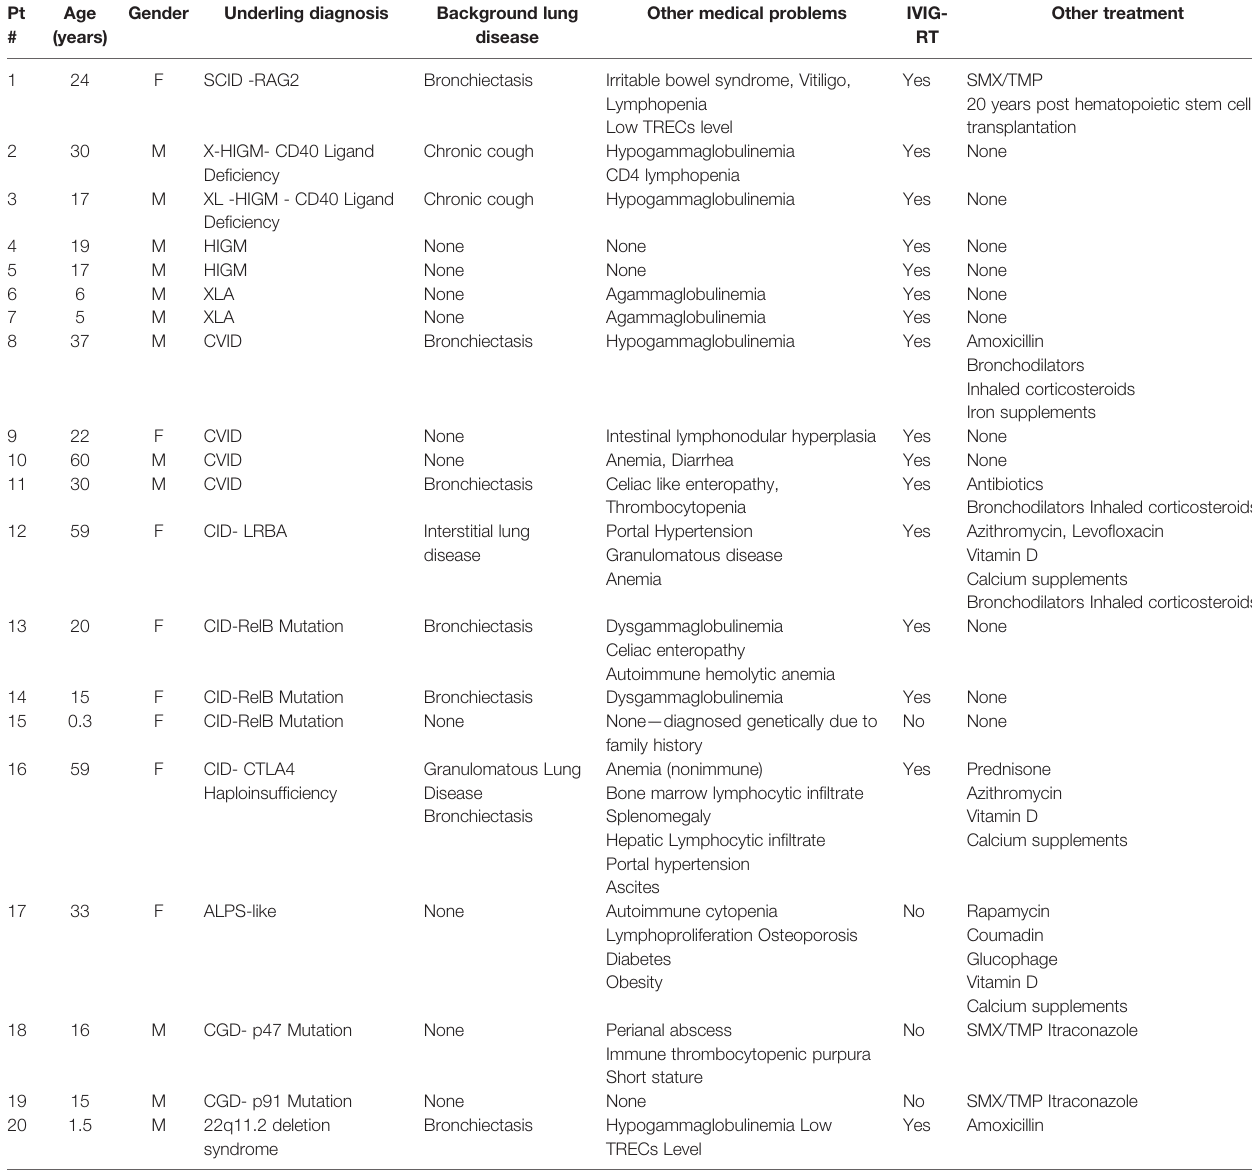
TABLE 1 | Demographic and clinical data of 20 patients with Primary immunode fi ciency before positive SARS-CoV-2 test. Pt Age # (years)